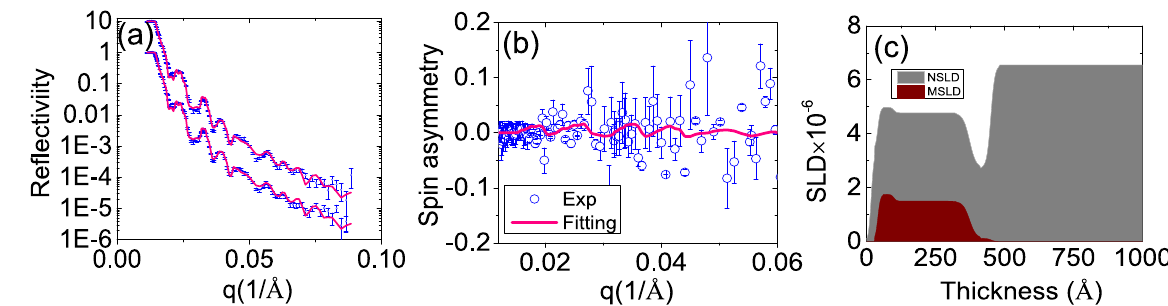
Figure 6. ( a ), ( b ), and ( c ) are spin reflectivity, spin asymmetry and NSLD and MSLD profile of the sample deposited under PO 2 = 10 − 5 torr. The solid line (magenta) is the fitting curve and the circles represents experimental data (blue). In order to see clearly, the Y axis of MSLD has been multiplied by 50